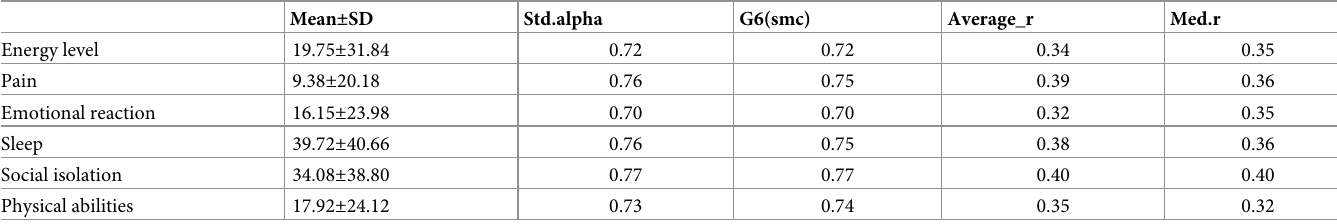
Table 1. Questionnaire reliability and validity analysis.